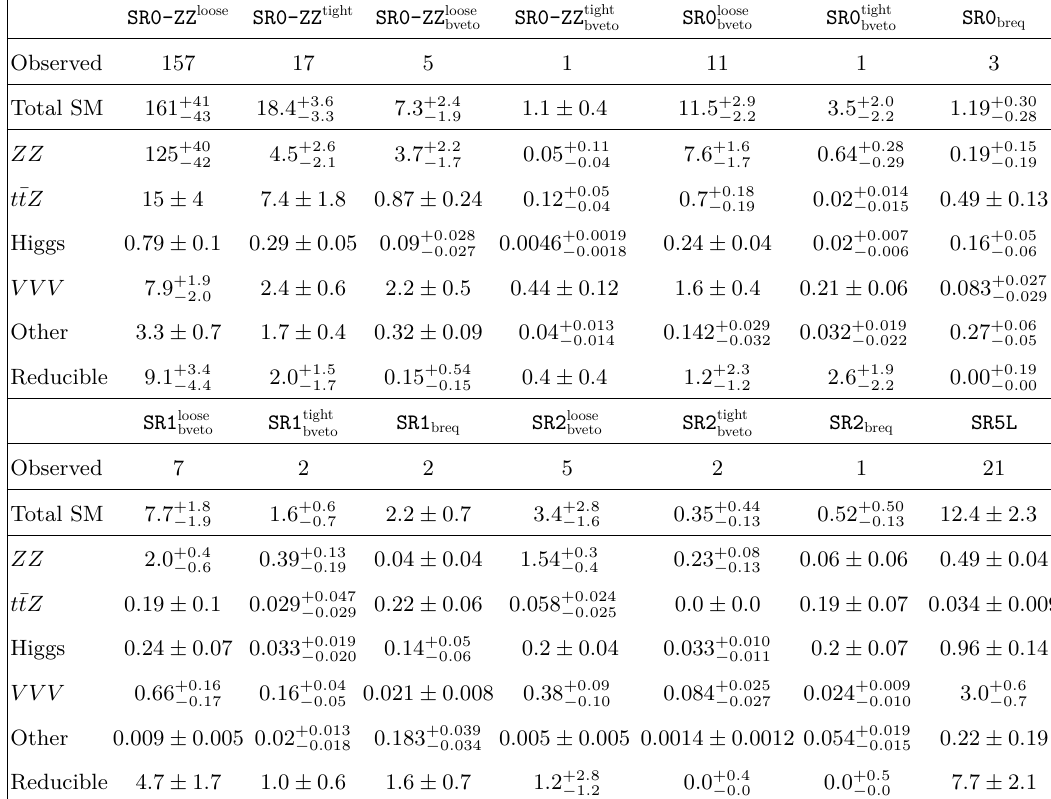
Table 9. Expected and observed yields for 139 fb − 1 in the signal regions after the background- only fit. “Other” is the sum of the tWZ , t ¯ tWW , t ¯ tZZ , t ¯ tWZ , t ¯ tWH , t ¯ tHH , t ¯ ttW , and t ¯ tt ¯ t backgrounds. Both the statistical and systematic uncertainties in the SM background are included in the uncertainties